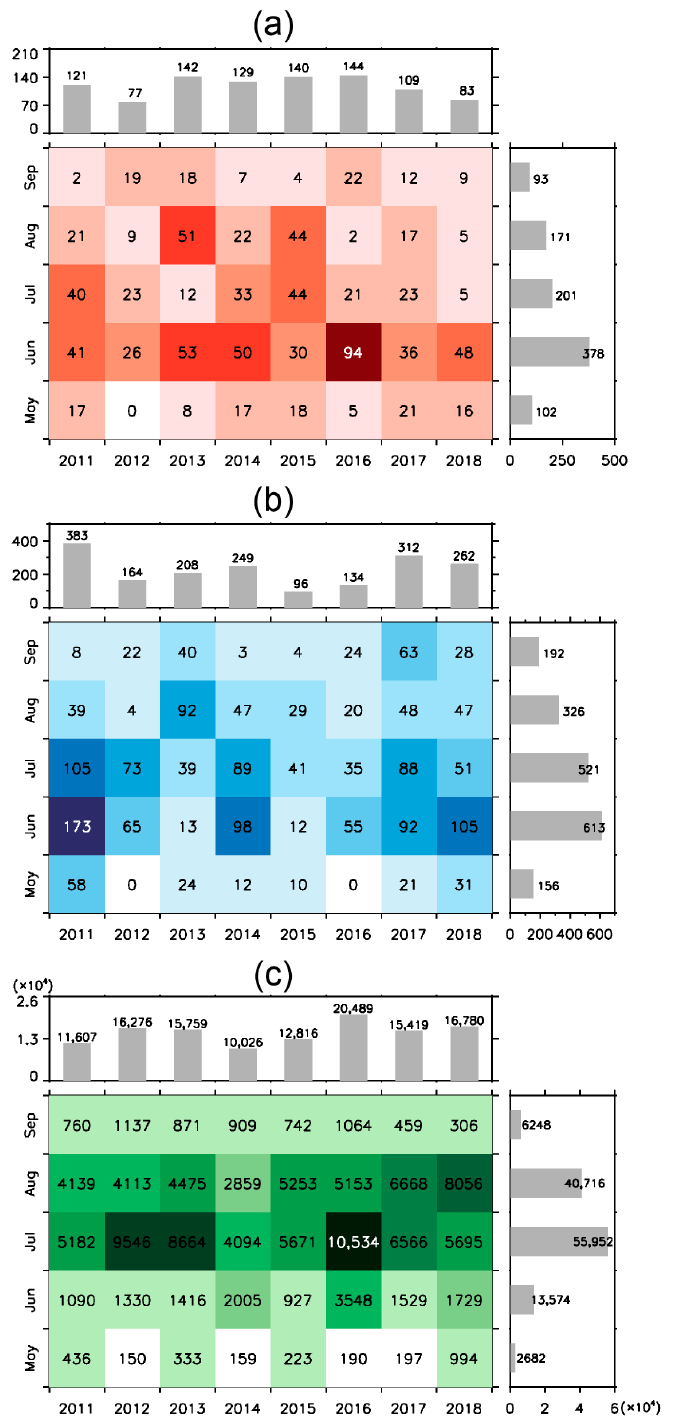
Figure 5. Yearly and monthly distributions of the occurrence frequencies of all ( a ) hail, ( b ) THW, and ( c ) SDHR events during the warm seasons of 2011–2018 over North